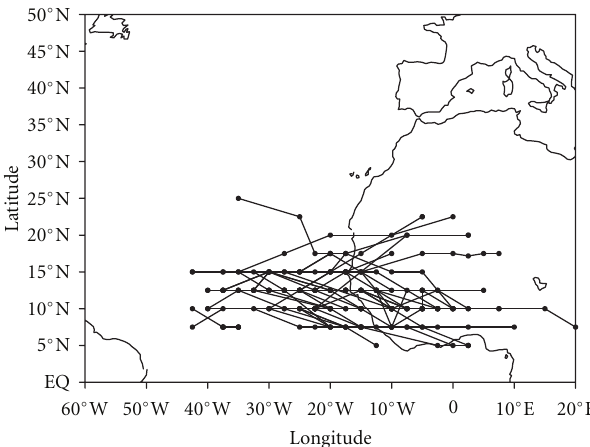
Modulus of wavelet analysis (AEWs with TCs)